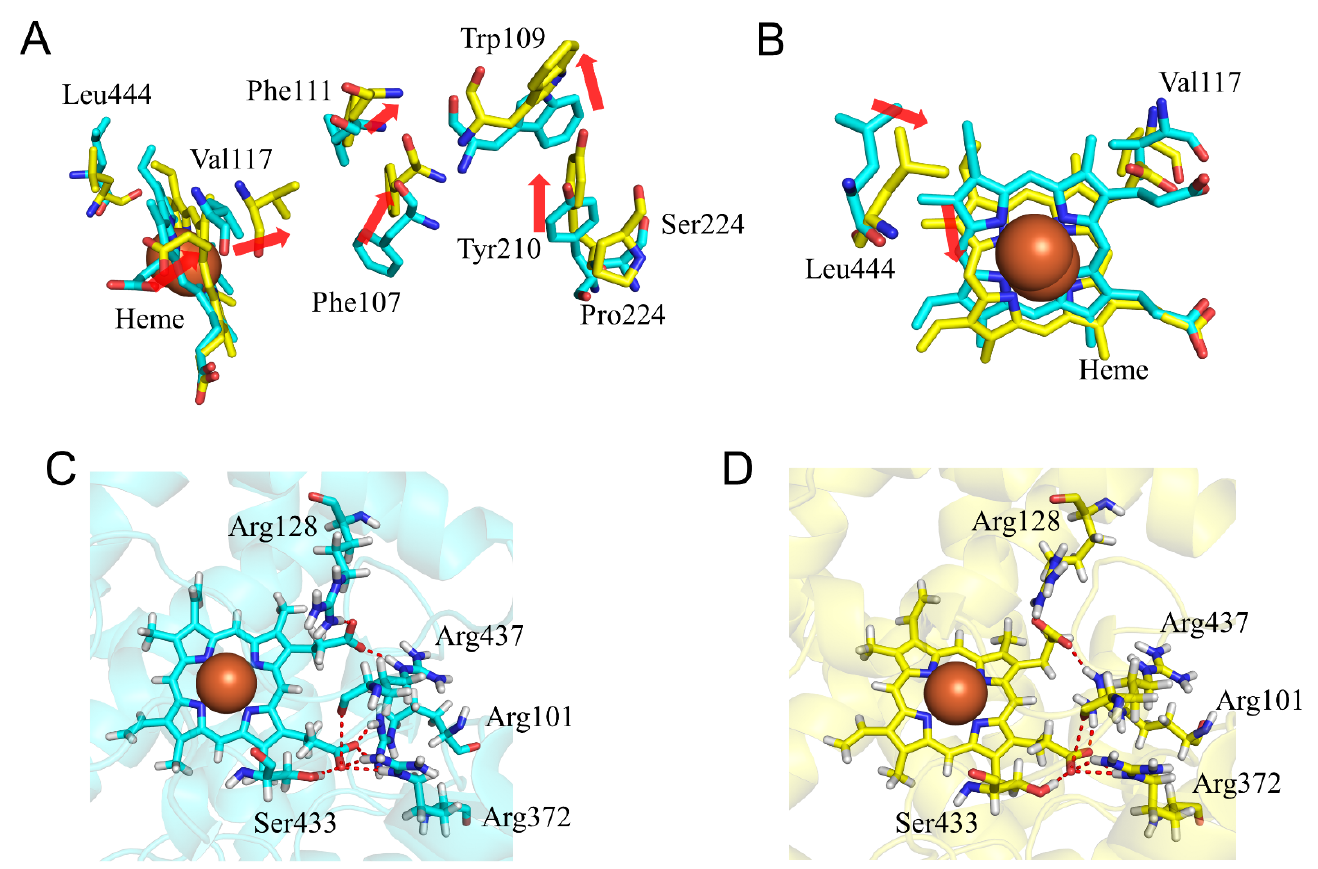
Figure 6. Structural change in CYP2A6.11 ( A , B ). The wild type ( C ) and CYP2A6.11 ( D ) are shown in cyan and yellow, respectively. In ( A , B ), all hydrogen atoms are omitted. Nitrogen, oxygen, and hydrogen are displayed in blue, red, and white, respectively, in the stick model. Iron is shown as an orange sphere by a model written as van der Waals radius. The red dotted lines indicate the hydrogen bonds. The red arrows indicate the shift in CYP2A6.11.